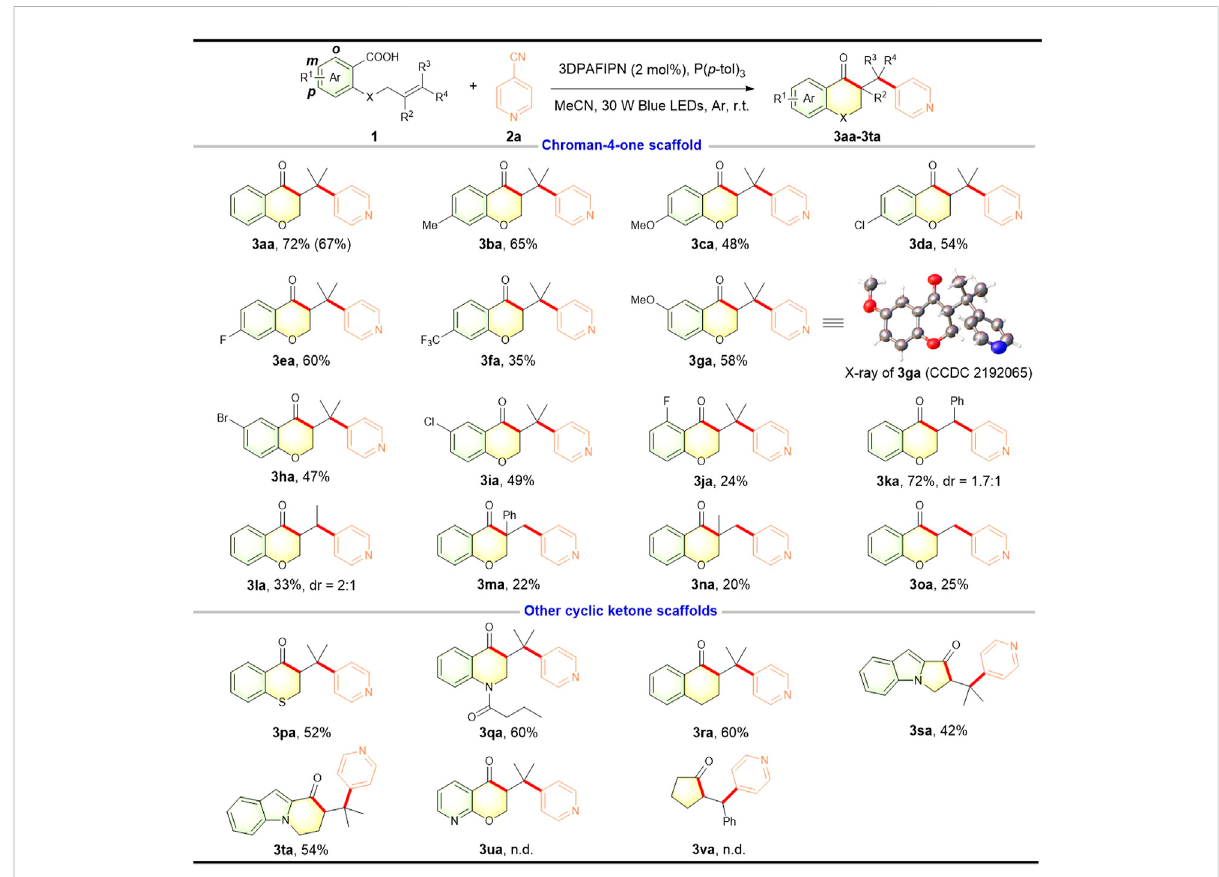
FIGURE 2 Scope ofalkenoic acids. Reaction conditions: 1 (0.3 mmol), 2a (0.45 mmol),3DPAFIPN(2 mol%), P( p -tol) 3 (0.6 mmol),MeCN (6 ml), 30 Wblue LEDs, argon atmosphere, r.t., 24 h. The isolated yield is based on 1 . Isolated yield in parentheses is obtained on a 1.0 mmol scale.